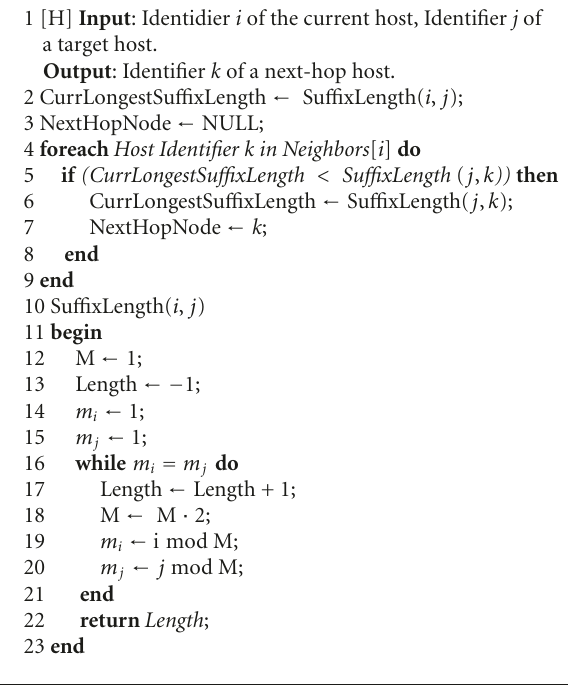
Algorithm 1: FindNextHopHost.